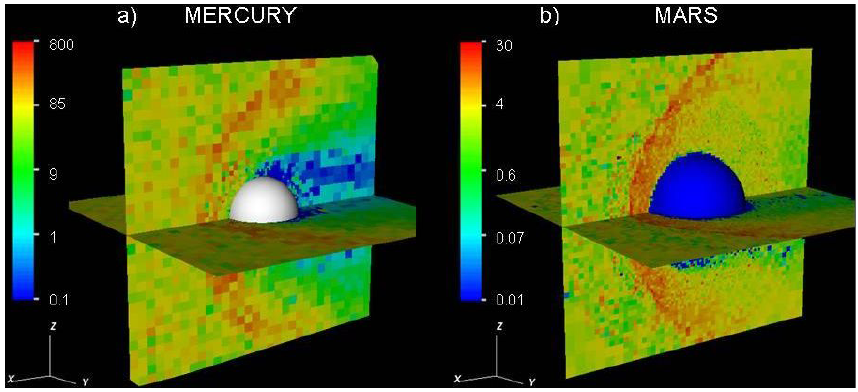
Fig. 1. Planetary plasma environments in the HYB model: (a) Mercury based on the HYB-Mercury model and (b) Mars based on the HYB-Mars model. The colors in the y =0 and z =0 planes gives the density of the solar wind protons in cm − 3 . The radius of Mercury in panel (a) is 2440km and Mars in (b) is 3393km. In the figure the solar wind is flowing from left to right and it forms a bow shock around the planets. These plasma parameters from HYB models can automatically be used as input parameters in the HYB-em model.